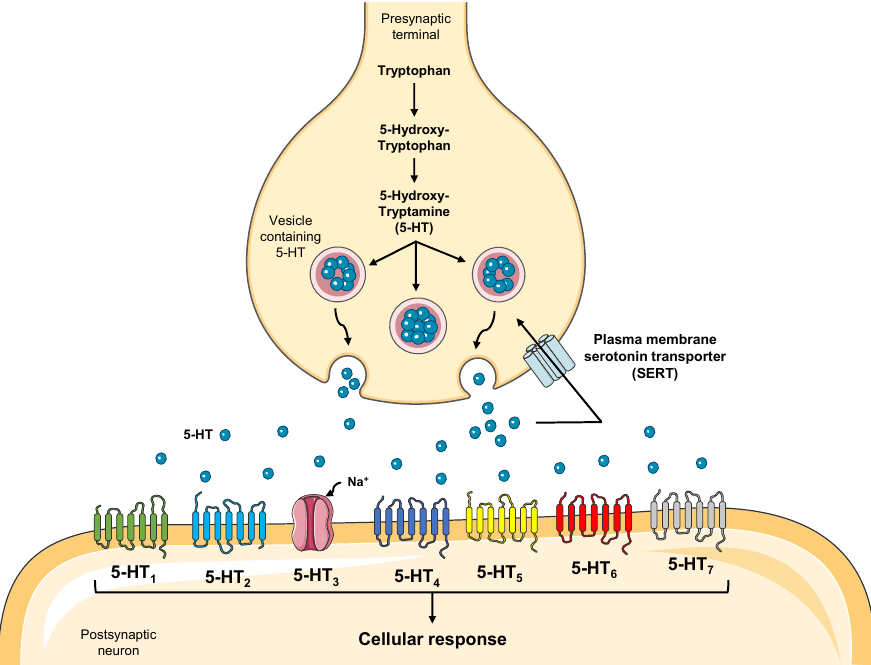
Figure 1. Representation of serotonin production by the CNS and major serotonin receptor families. 5-HT is produced at the presynaptic end of neurons and is originated from the metabolism of tryptophan. This neurotransmitter is transported into vesicles that travel to the synaptic cleft, where they release this monoamine. 5-HT may interact with seven families of receptors (5HT 1–7 ) or can be reuptake by the SERT transporter. 5-HT receptors are mostly G protein-coupled, except for the 5-HT 3 receptor, which is a ligand-gated ion channel. The binding of this monoamine can trigger a wide range of cellular responses [2].